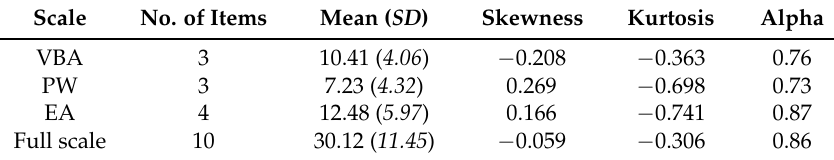
Table 2. Descriptive statistics for the 10-item PPFQ (PPFQ-10) subscales and full scale ( n =